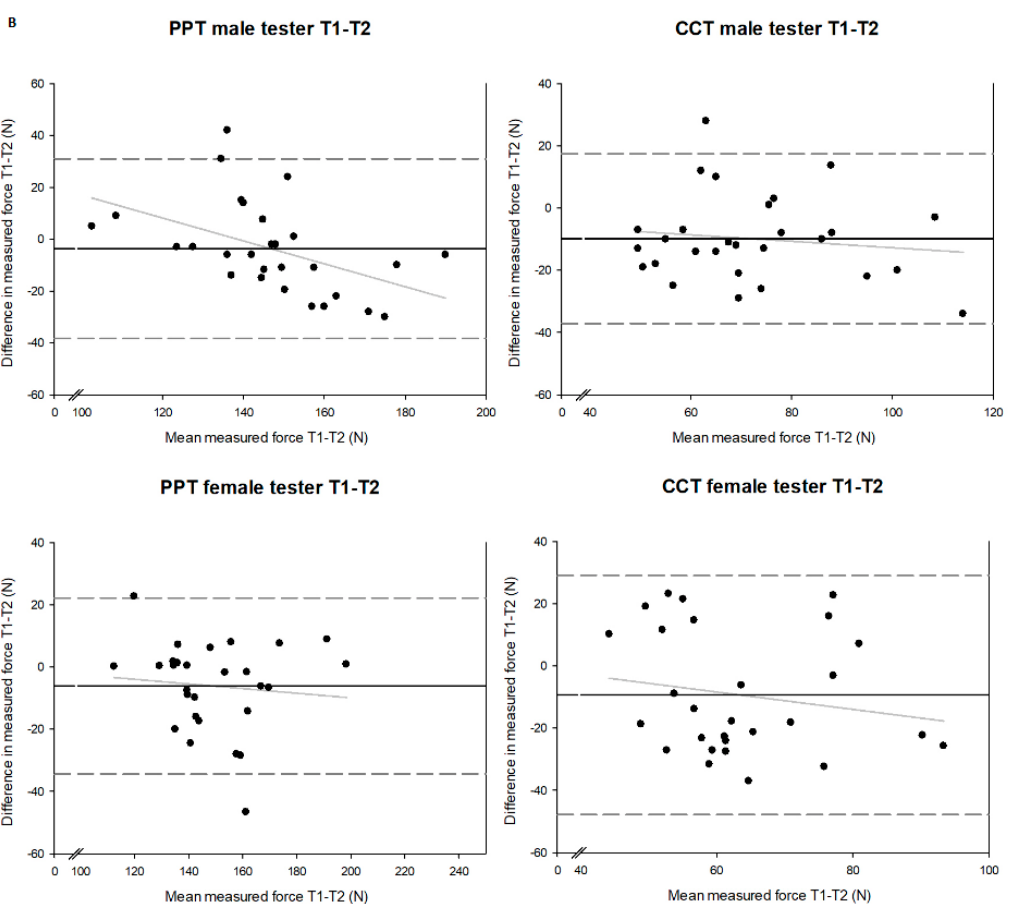
Figure 3. Bland and Altman plots representing mean differences and 95% limits of agreement. ( A ) Between trial 1 and trial 2 for both testers in the first testing session (T1). ( B ) Between first (T1) and second (T2) testing sessions for both testers.